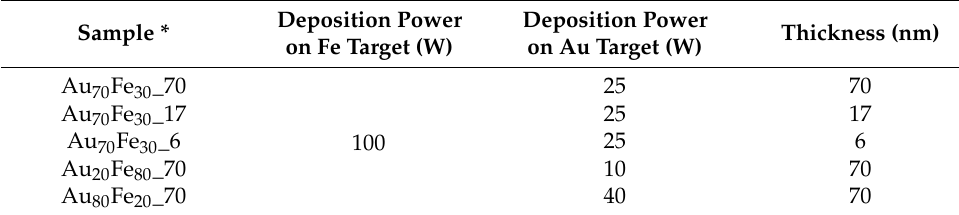
Table 1. Deposition parameters of the RF magnetron sputtering nanophase